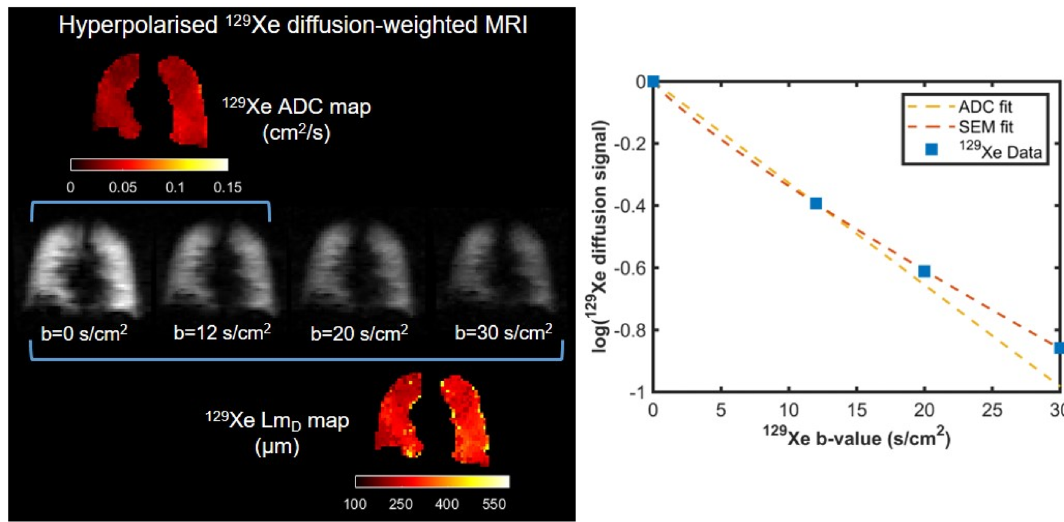
Figure 5. Example hyperpolarised 129 Xe diffusion-weighted (DW) MRI data from one volunteer. (Left) Maps of ADC and Lm D values calculated from 129 Xe DW-MRI. (Right) Representative global 129 Xe signal as a function of b-value, ADC- and SEM-fits obtained for the same